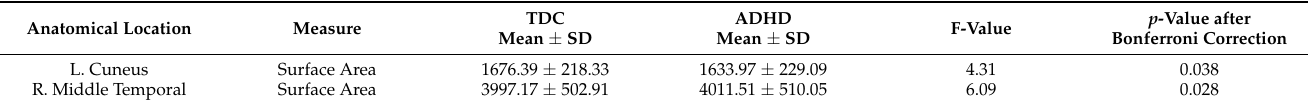
Table 2. Gray matter neuroimaging measures that show significant differences between control and ADHD groups with age, sex, and ETIV (for volume and area) as covariates.